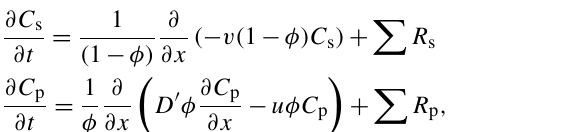
Table 4. Chemical species included in the diagenetic model. Species Notation Organic carbon a Solid Iron oxides a Solid Iron-oxide-bound phosphorus a Fe ox P ∝ ,β,γ Adsorbed and co-precipitated Iron monosulfide Elemental